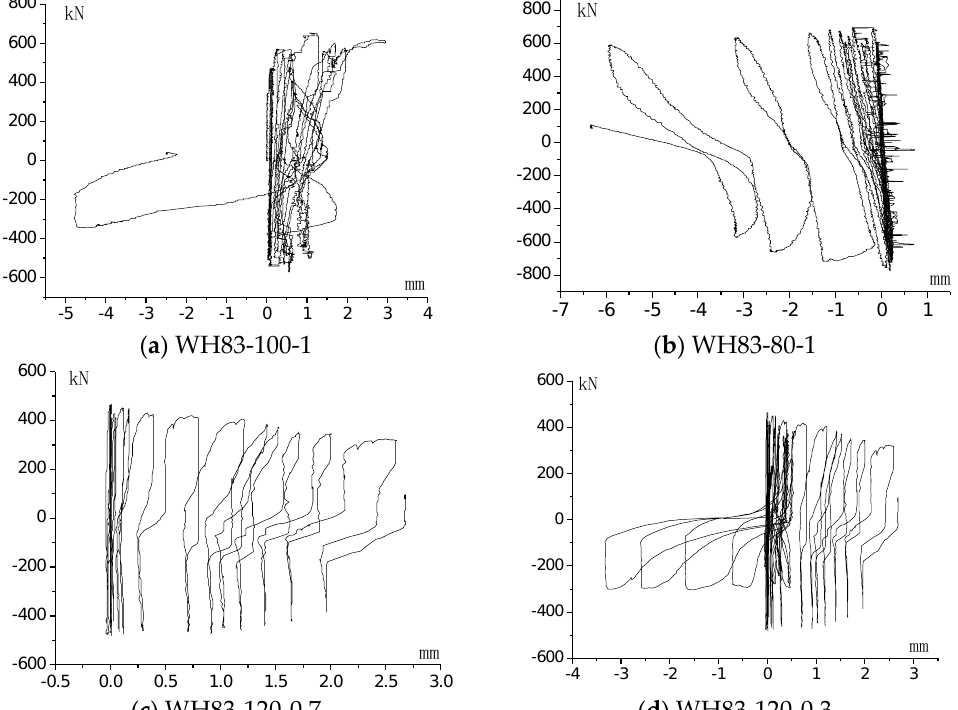
Figure 10. Load-displacement curve between inner leaf and outer leaf (LVDTs 2-5).